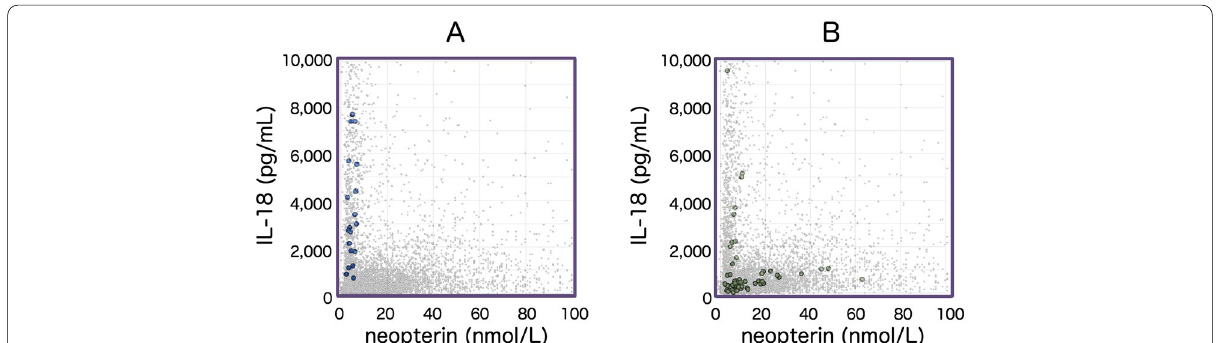
Fig. 5 IL-18/neopterin plot patterns of typical and atypical FMF. Serum concentrations of IL-18 and neopterin were compared between 21 typical ( A ) and atypical 59 FMF ( B ) patients. Typical FMF patients consisted of patients with typical clinical manifestations and pathogenic mutations within exon 10 of MEFV . Atypical FMF patients had variable symptoms, and most of them had MEFV mutations within exon 2 and/or exon 3. Small dots represent data from 9060 control